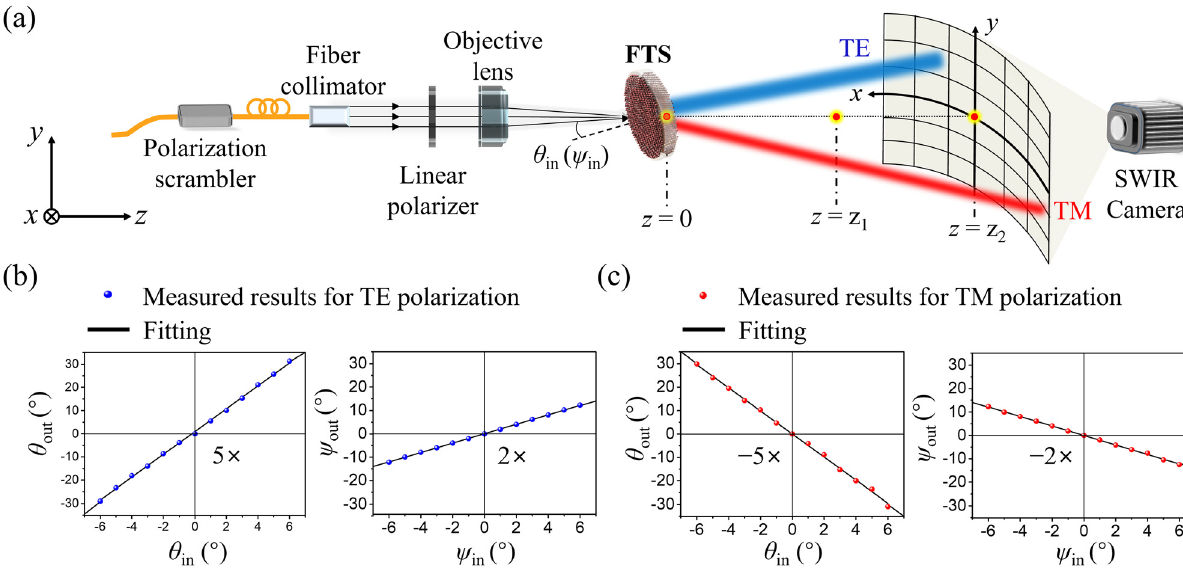
Figure 4: Transfer characteristics of the developed FTS: (a) Experimental setup for capturing output beams at various incident angles. Comparison between the experimental angular magnifications and fitted trajectories for (b) TE and (c) TM